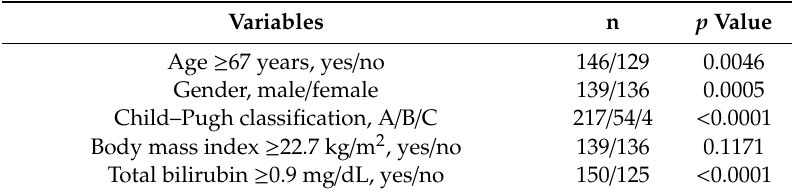
Table 3. Univariate analyses of factors linked to the incidence of composite hepatic events.